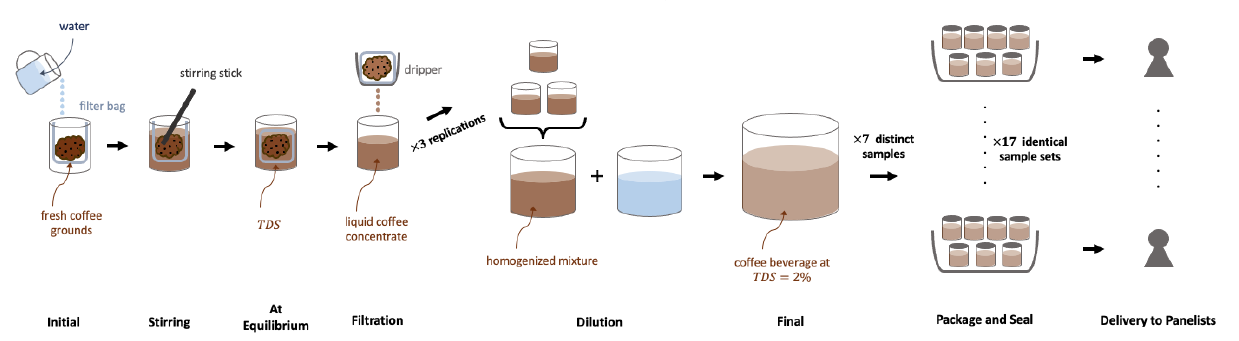
Figure 1. A schematic of the coffee brewing process and packaging for a remote COVID-19 descriptive analysis.